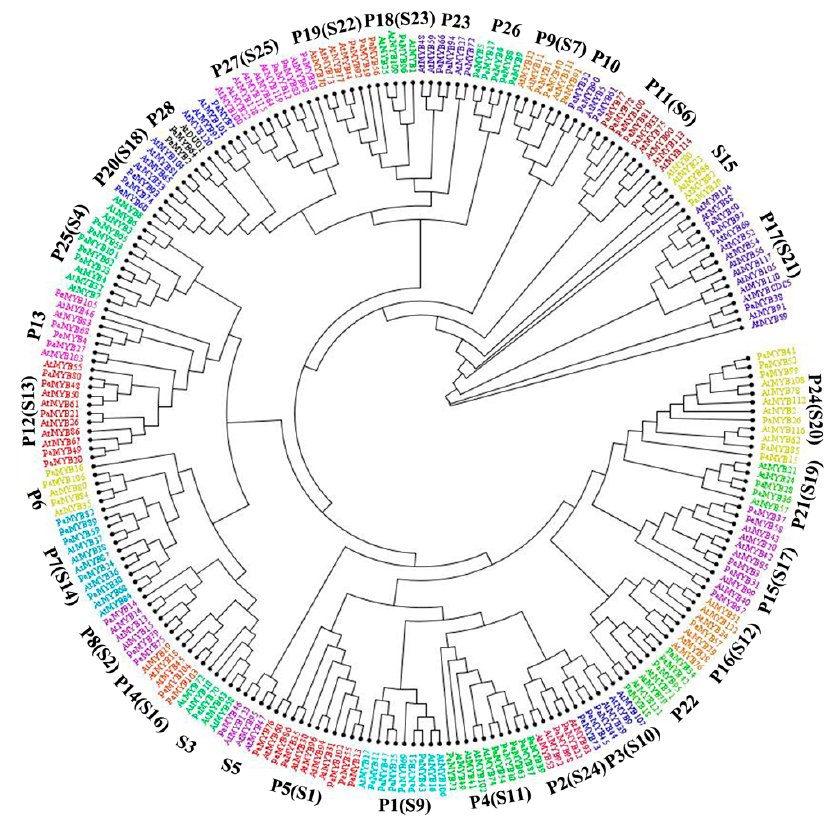
Figure 3. Phylogenetic tree of R2R3-MYB proteins between Petunia axillaris (P) and Arabidopsis thaliana (S). Neighbor-joining phylogeny was determined by MEGA 10.1.8. The colored shadow marks the subgroups of the R2R3-MYBs.